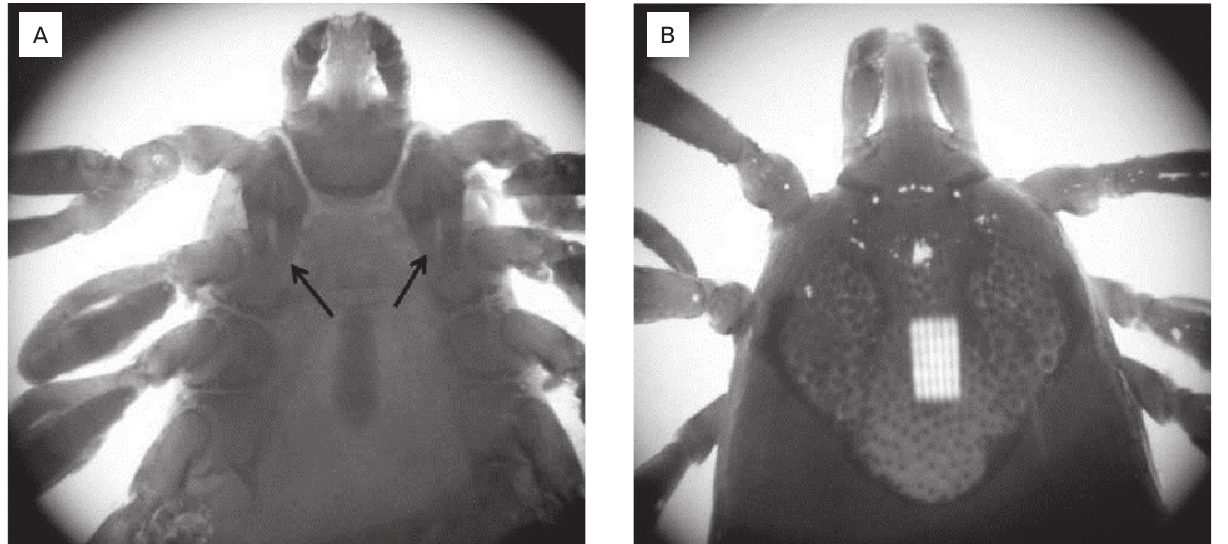
Figura 1. Amblyomma ovale. (A) Espinhos longos na Coxa I. (B) Fêmea